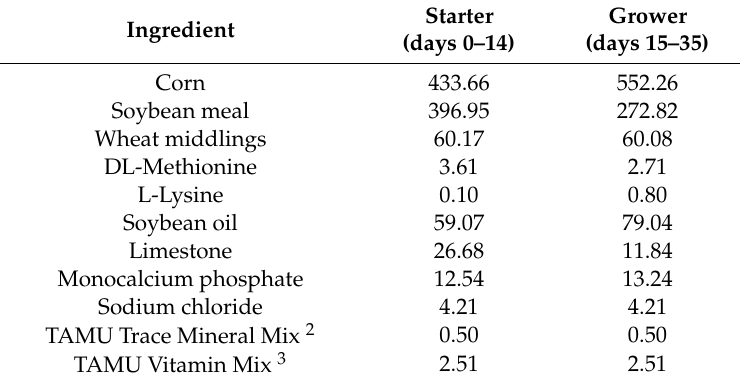
Table 1. Ingredient composition (g / kg) of basal diets for each growing period 1